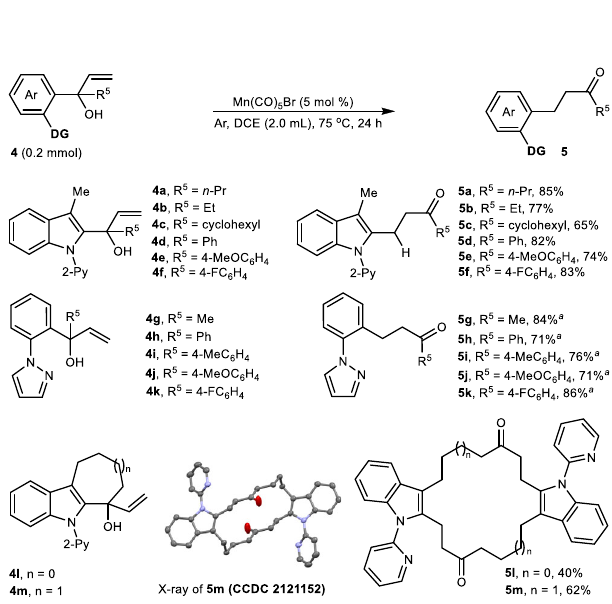
Fig. 3 | Tertiary allylic-alcohol scope. All the reactions were performed in a sealed tube, followed by fl ash chromatography on SiO 2 . The yields were deter- mined by isolation. a The reaction temperature is 100 o